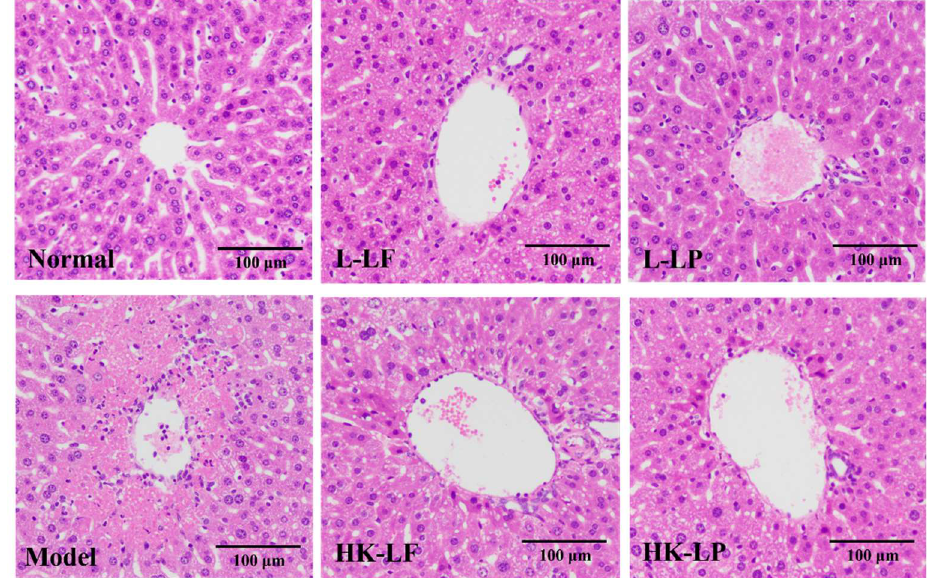
Figure 4. Histopathology observation of liver.